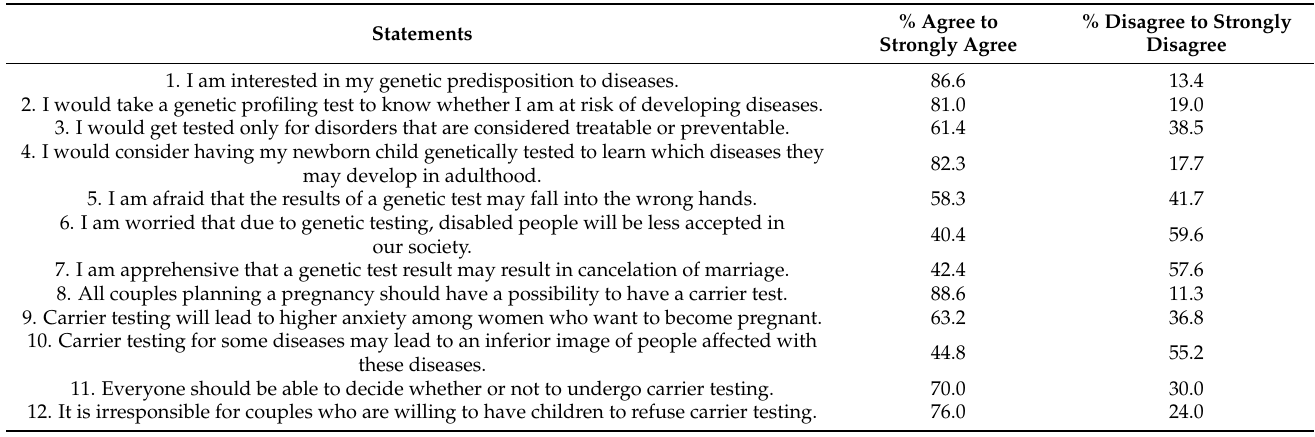
Table 3. Participants’ Attitudes Toward Genetic Testing (N =